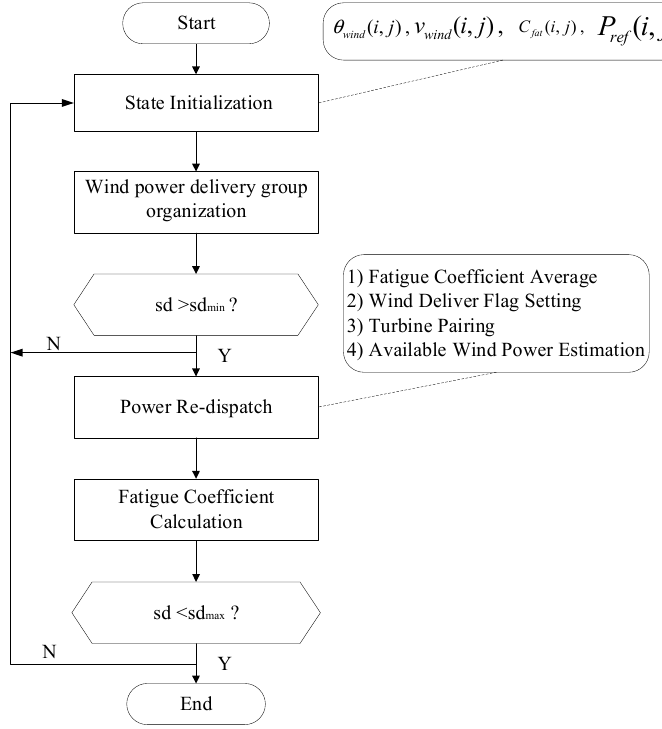
Figure 6. Workflow of the wind farm main controller.